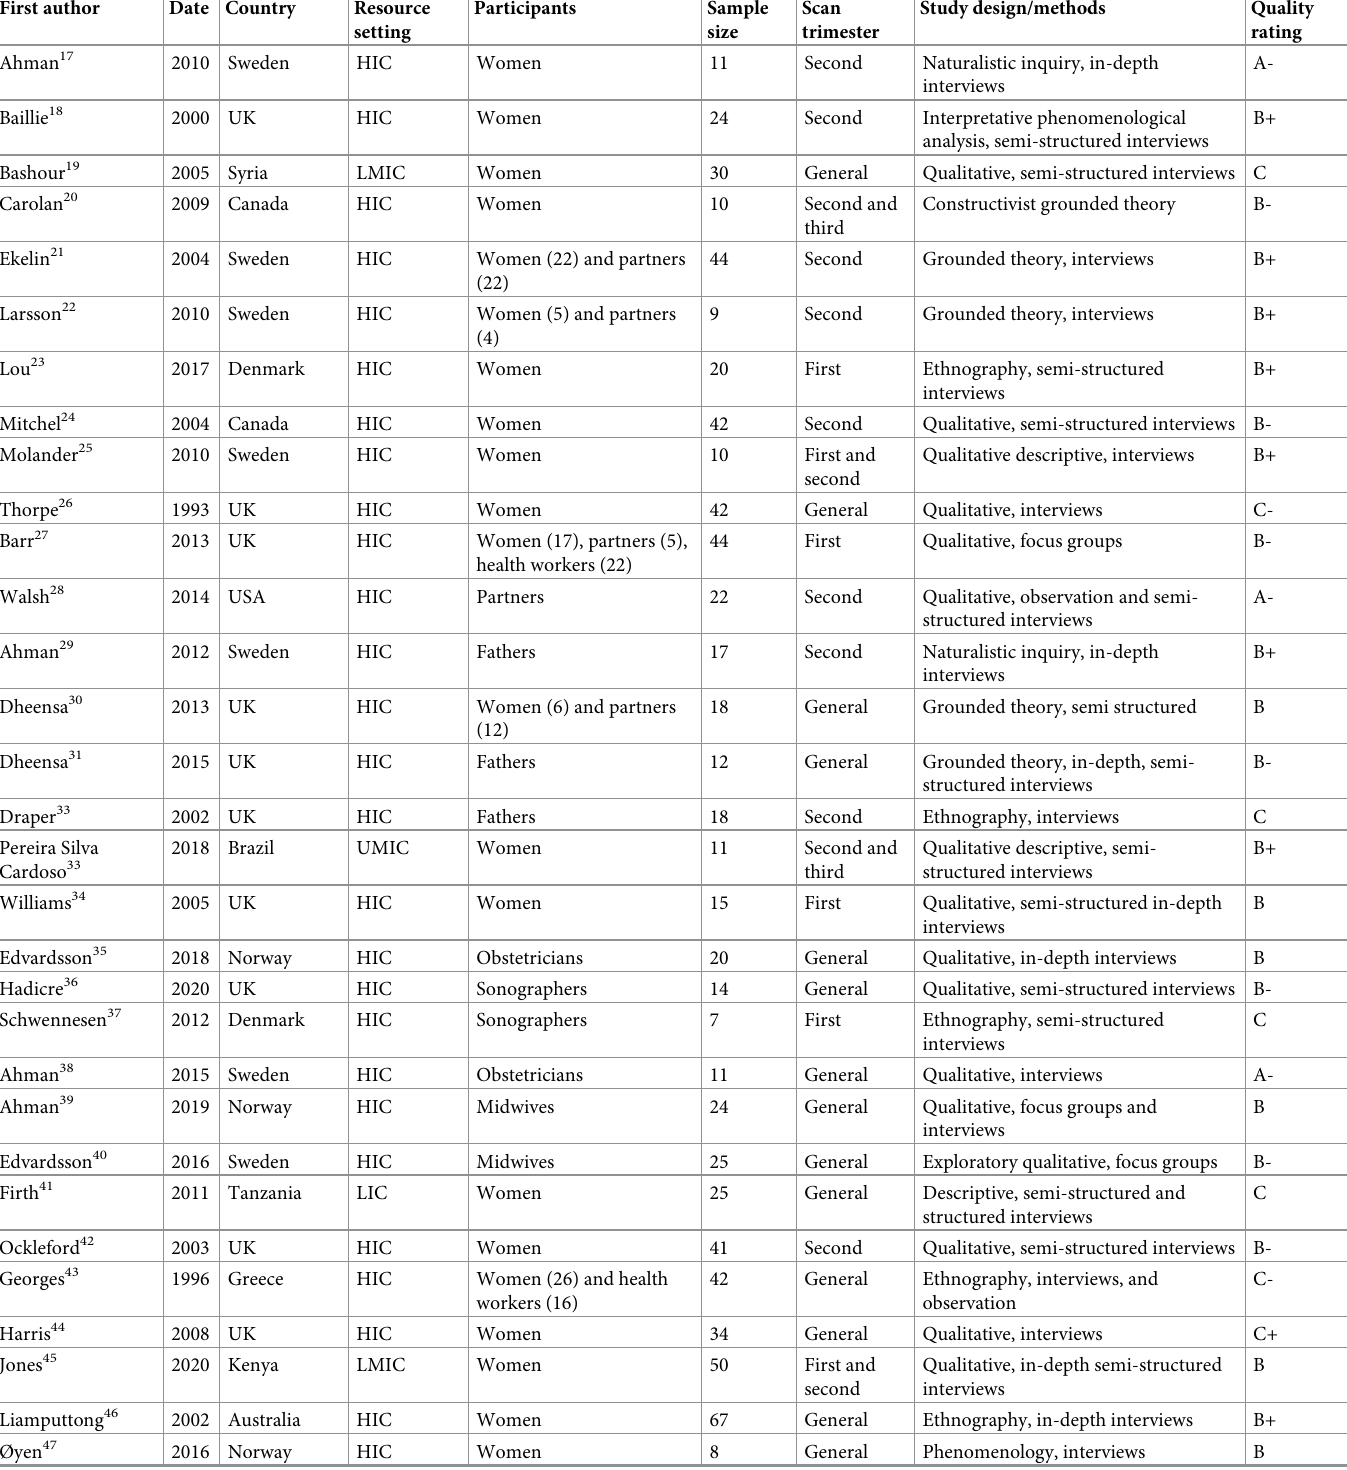
Table 1. Characteristics and quality rating of included